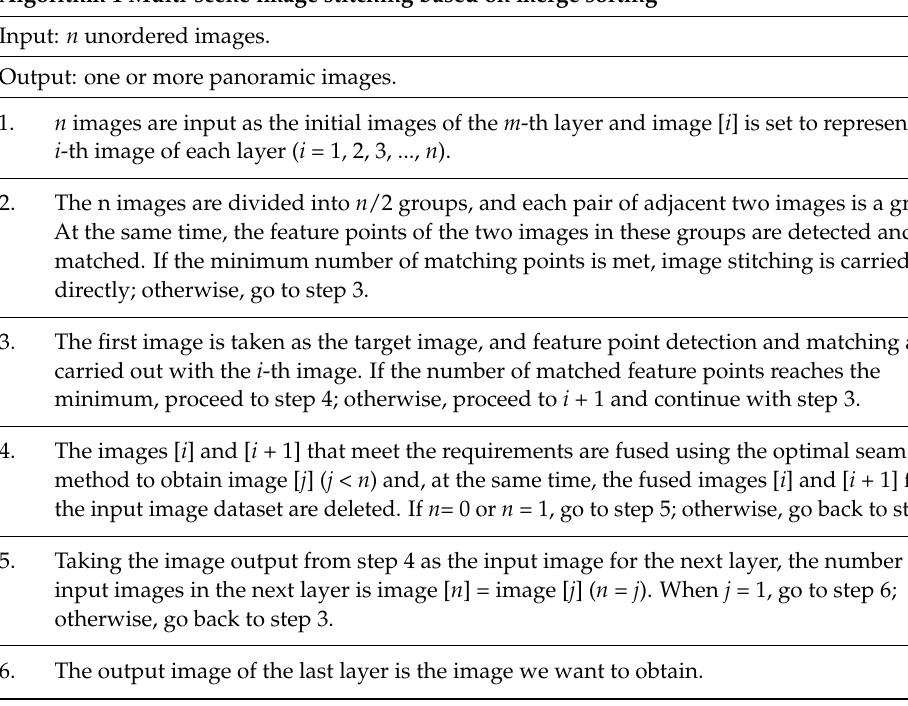
Algorithm 1 Multi-scene image stitching based on merge